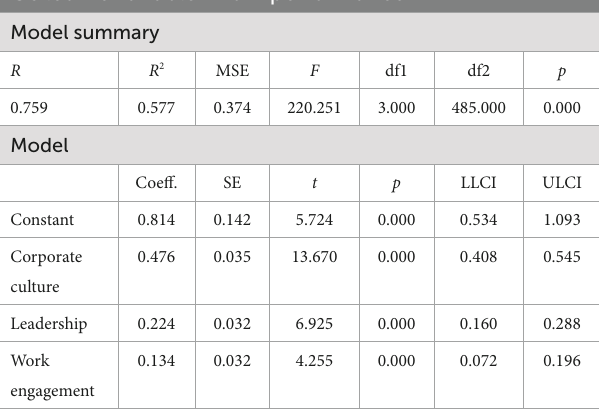
TABLE 6 Influence of corporate culture, leadership, and work engagement on work performance. Outcome variable: Work performance Model summary